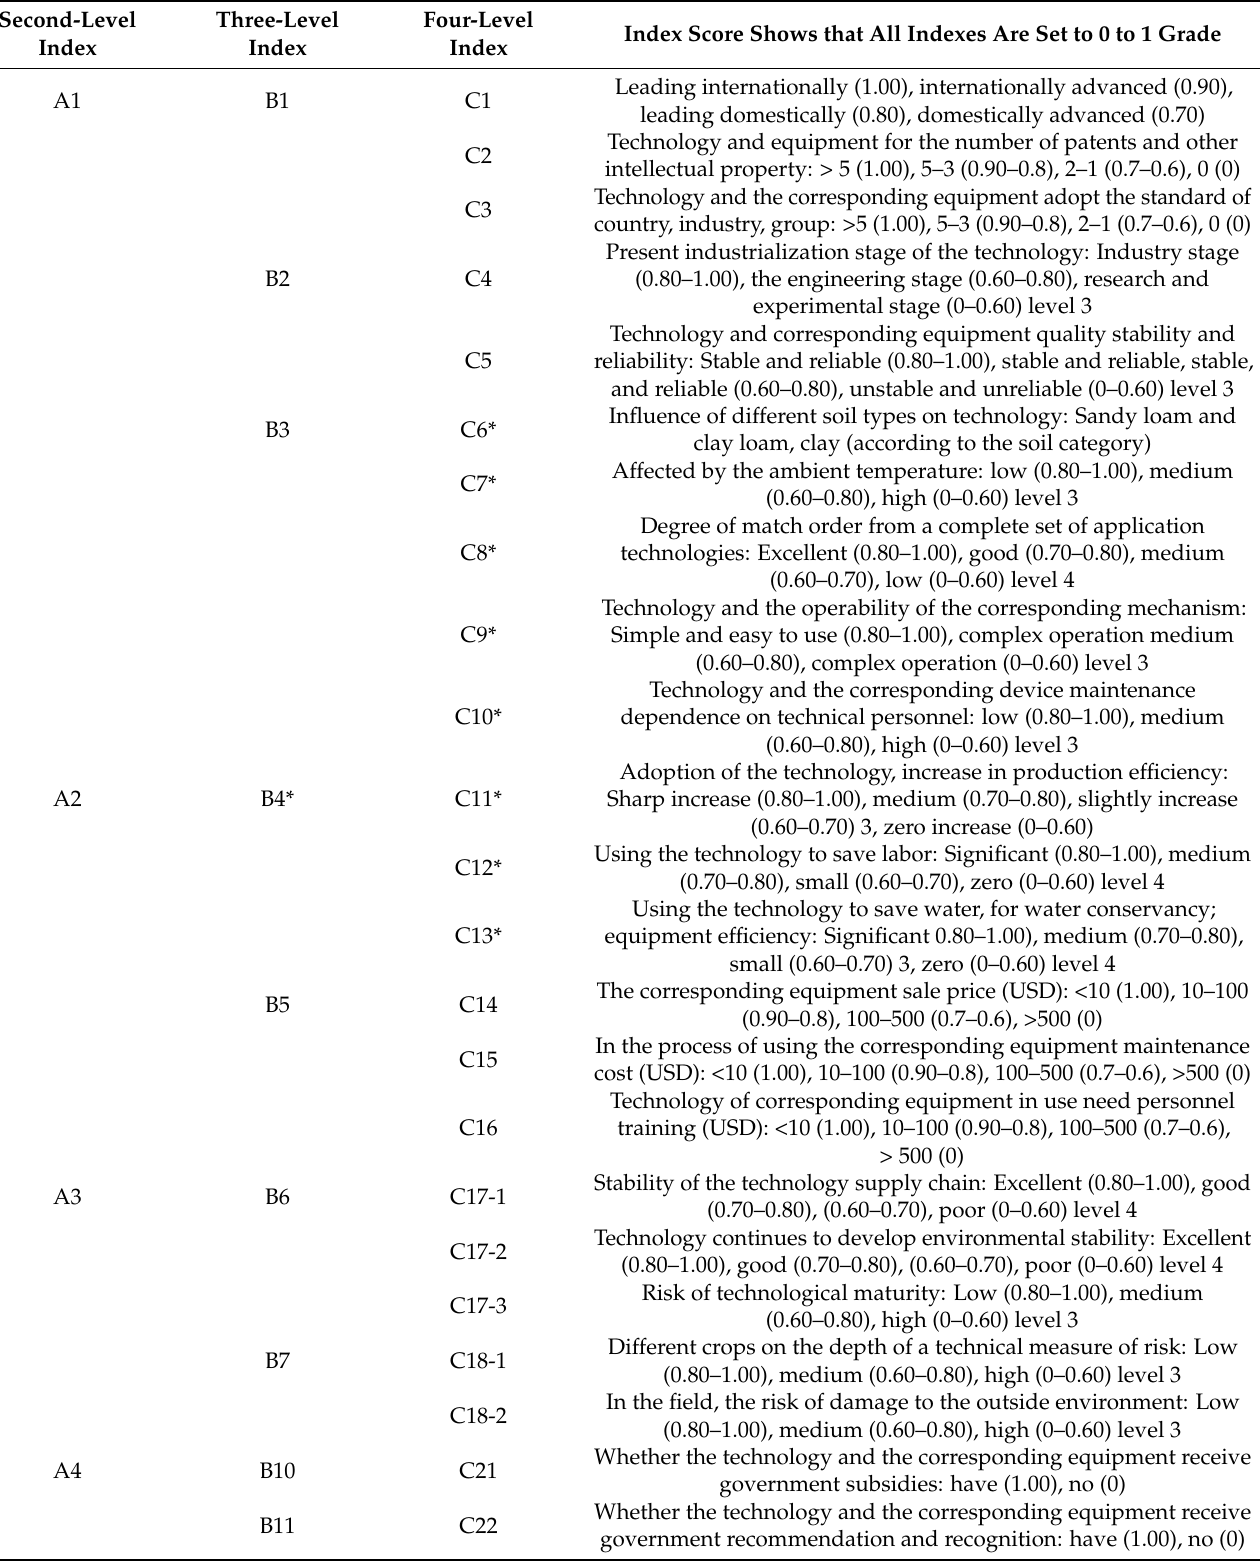
Table 5. Evaluation index system of soil water sensing